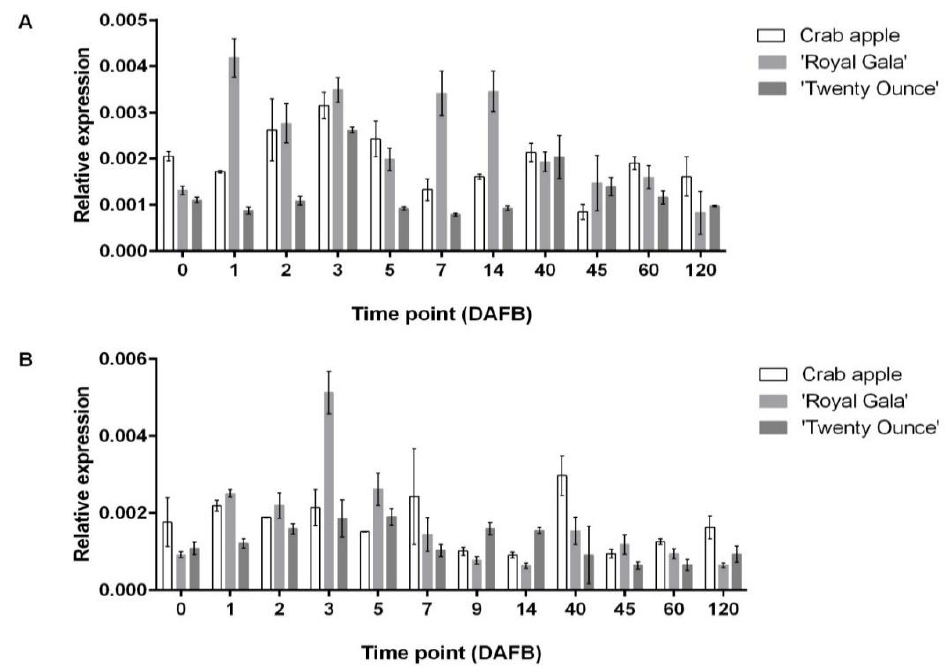
Figure 9. Differential expression of MdARF106 in three cultivars during Season 2, relative to the control gene, MdGAPDH . ( A ) Relative expression in biological Replicate 1 (Rep1). ( B ) Relative expression in biological Replicate 2 (Rep2). Error bars = standard deviation; n = 3 (technical replicates). The expression between time points and cultivars were statistically different, ANOVA (two-factor), p - value ≤ 0.05.